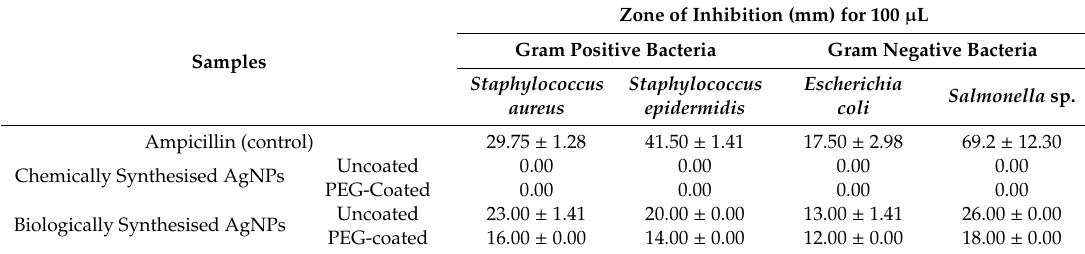
Table 3. Inhibitory activities of AgNPs from chemical and biological syntheses against multidrug-resistant bacterial